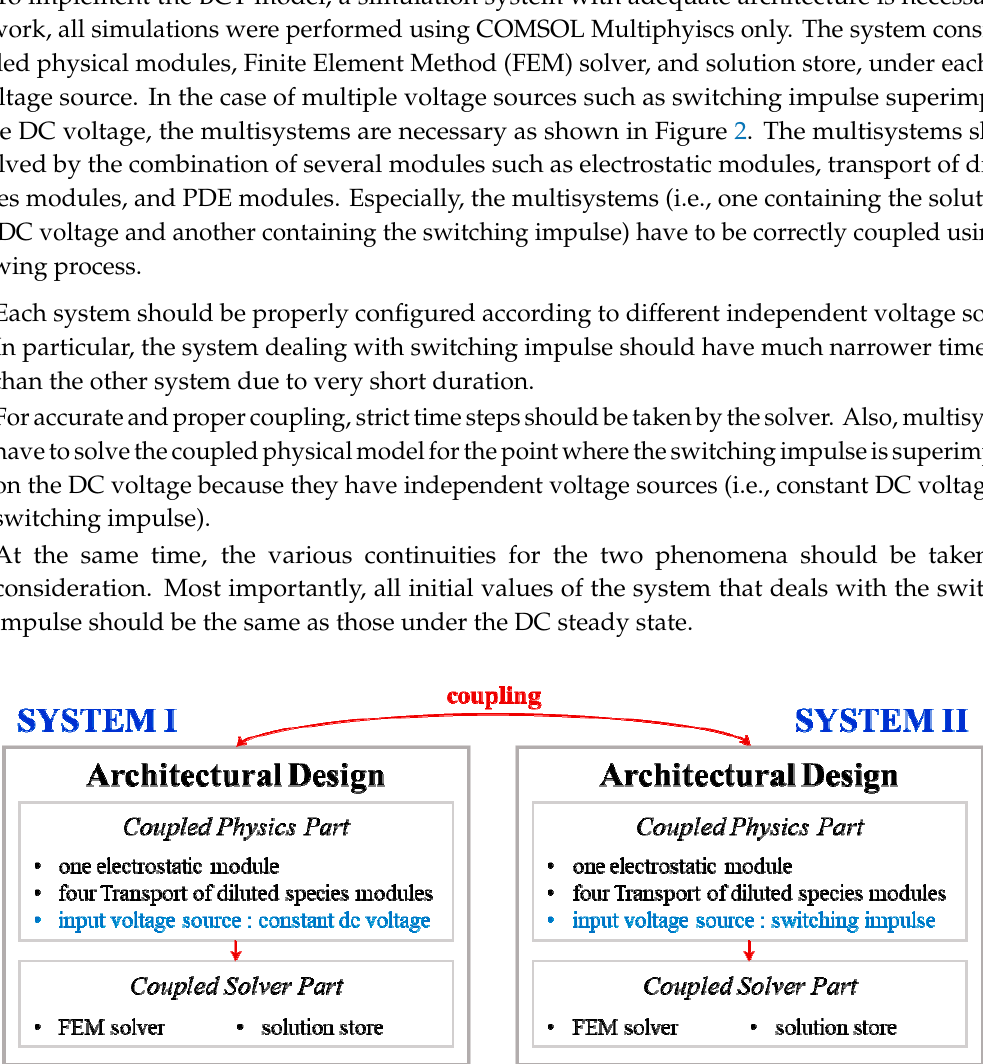
Figure 2. Implementation process based on multisystems in COMSOL.